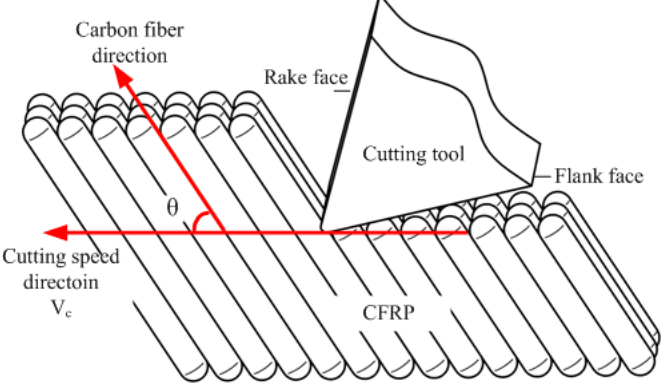
Figure 3. Scheme of fiber orientation angle.